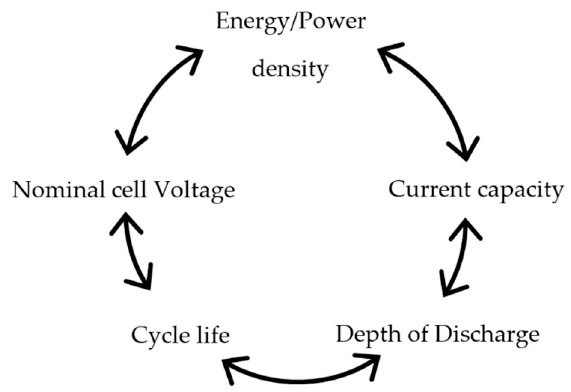
Figure 1. Battery key property interdependence, adapted from